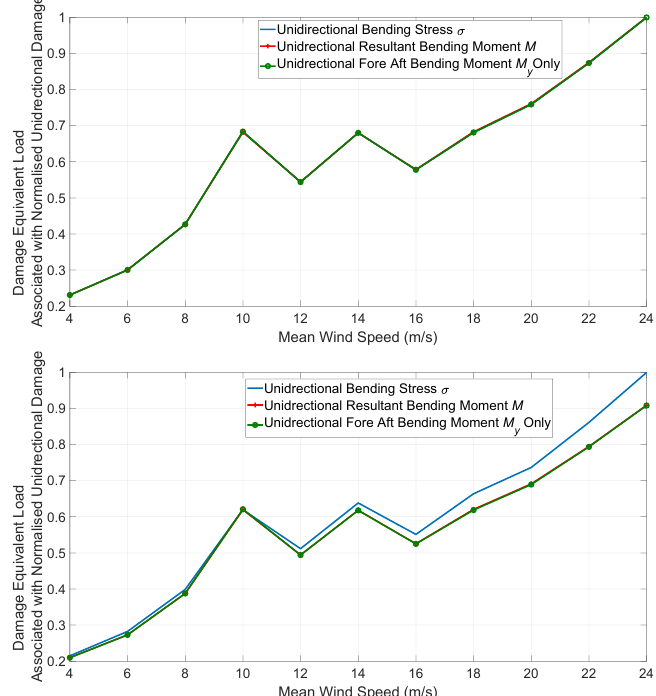
Figure 18. Normalised damage equivalent load associated with uni-directional fatigue damage using 10 min bending stress σ , resultant bending moment M and fore-aft bending moment M y time series where θ and τ are fixed at 0 ◦ ( above ) and where θ and τ are fixed at 60 and 30 ◦ , respectively ( below ). As stated previously, according to design standards, the wind turbine towers have to withstand the worst-case load. Here, the worst-case load is taken to be the uni-directional load, where all the wind coming from a single direction is acting on the point on the wind turbine towers circumference, which undergoes the highest damage. As such, it is common practice to assume that the point with the largest damage lies on the axis of wind direction distanced from a neutral axis equal to the tower radius. This corresponds to setting θ = τ = 0 ◦ in the closed-form solution to calculate the worse case scenario or uni-directional damage and is taken as the design reference damage in the rest of this